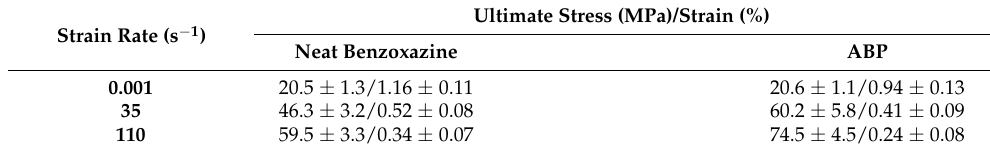
Table 1. Ultimate stress and strain of neat benzoxazine and ABP under different strain rates.